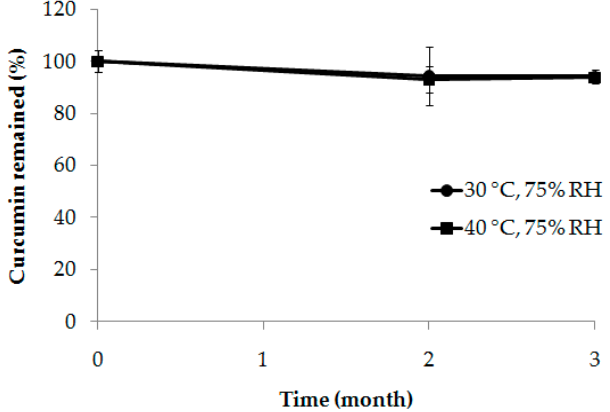
Figure 5. The remaining curcumin in the composite membrane (CM200:8) after being stored at 30 ± 2 °C, 75 ± 5% RH, and 40 ± 2 °C, 75 ± 5% RH for 1, 2, and 3 months.